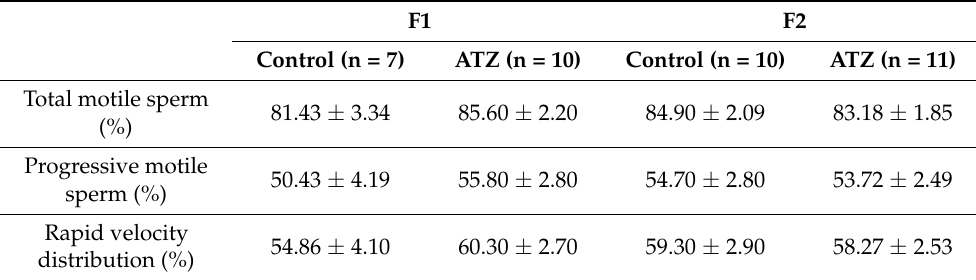
Table 5. The effect of atrazine on sperm motility at 6 months of age in the F1 and F2 measured using CASA. No significant differences were found between the control and ATZ treatment for all parameters. Data are mean ± SEM, with >3 L per treatment, per